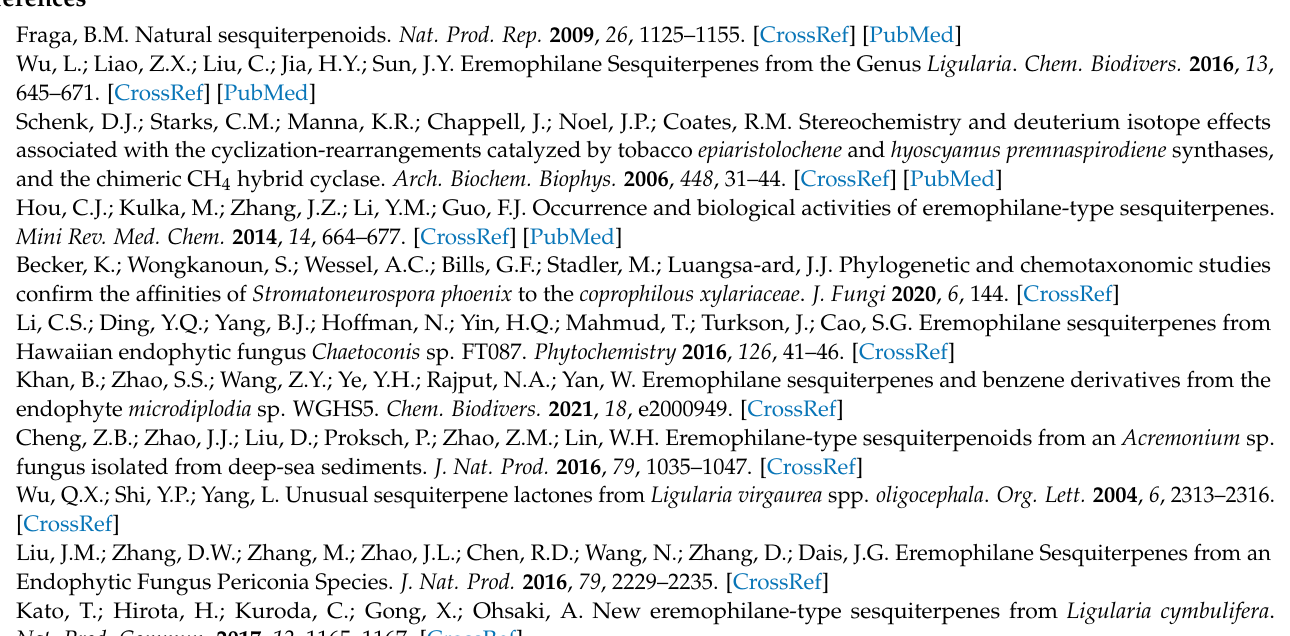
ECD spectra of 4 . Figure S5. 1 H NMR spectrum of 1 in CD 3 OD. Figure S6. 13 C NMR spectrum of 1 in CD 3 OD. Figure S7. HSQC spectrum of 1 in CD 3 OD. Figure S8. HMBC spectrum of 1 in CD 3 OD. Figure S9. COSY spectrum of 1 in CD 3 OD. Figure S10. ROESY spectrum of 1 in CD 3 OD. Figure S11. HRMS spectrum of 1. Figure S12. 1 H NMR spectrum of 2 in CD 3 OD. Figure S13. 13 C NMR spectrum of 2 in CD 3 OD. Figure S14. HSQC spectrum of 2 in CD 3 OD. Figure S15. HMBC spectrum of 2 in CD 3 OD. Figure S16. COSY spectrum of 2 in CD 3 OD. Figure S17. Roesy spectrum of 2 in CD 3 OD. Figure S18. HRMS spectrum of 2 . Figure S19. 1 H NMR spectrum of 3 in CD 3 OD. Figure S20. 13 C NMR spectrum of 3 in CD 3 OD. Figure S21. HSQC spectrum of 3 in CD 3 OD. Figure S22. HMBC spectrum of 3 in CD 3 OD. Figure S23. COSY spectrum of 3 in CD 3 OD. Figure S24. Roesy spectrum of 3 in CD 3 OD. Figure S25. HRMS spectrum of 3 . Figure S26. 1 H NMR spectrum of 4 in CD 3 OD. Figure S27. 13 C NMR spectrum of 4 in CD 3 OD. Figure S28. HSQC spectrum of 4 in CD 3 OD. Figure S29. HMBC spectrum of 4 in CD 3 OD. Figure S30. COSY spectrum of 4 in CD 3 OD. Figure S31. Roesy spectrum of 4 in CD 3 OD. Figure S32. HRMS spectrum of 4 . Figure S33. CD spectrum of 1 – 4 in